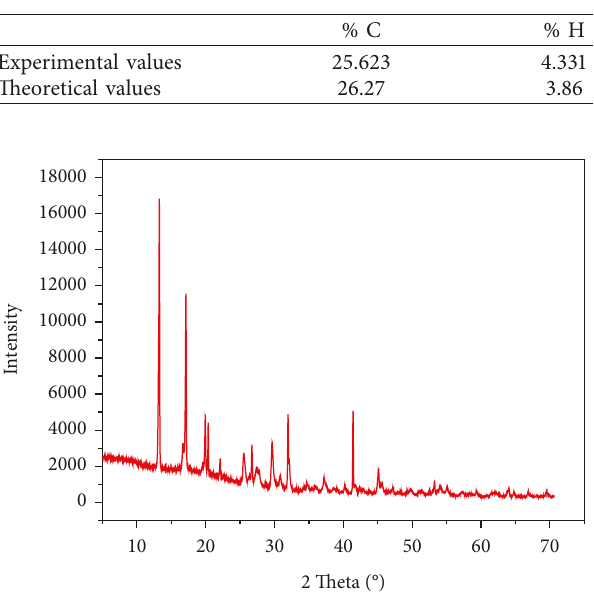
Figure 2: Powder X-rays diffraction of copper (II) fumarate.